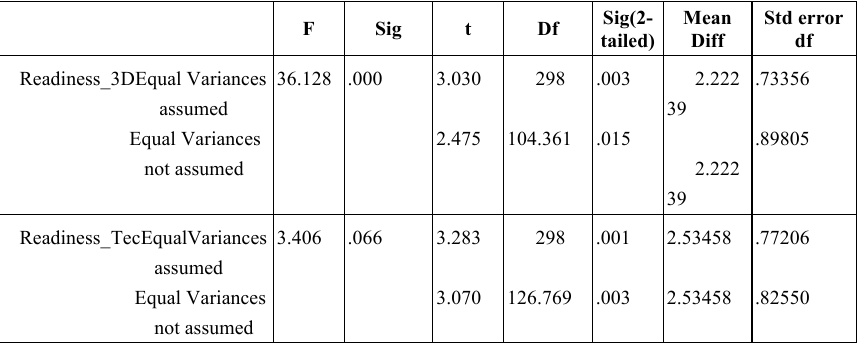
Table 6. Showing T test between nationality and the readiness